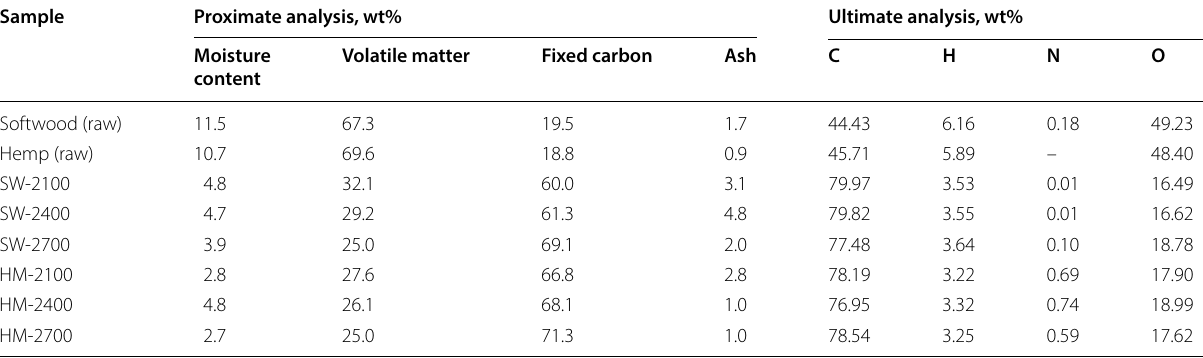
Table 5 Comparative analysis of chemical properties in biochar obtained from softwood and hemp Sample Proximate analysis,